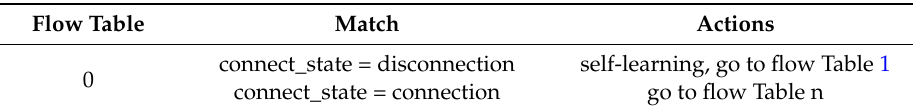
Table 1. Entries with different connect state match